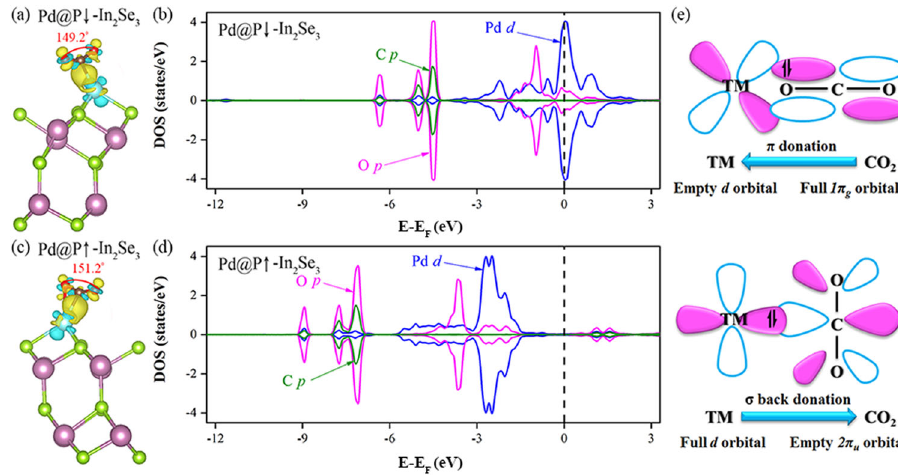
Fig. 2 Tunable activation of CO 2 by polarization switching. The differential charge density plots and partial density of states of CO 2 adsorbed on Pd@In 2 Se 3 ( a , b for Pd@P ↓ -In 2 Se 3 , and c , d for Pd@P ↑ -In 2 Se 3 ). e Simpli fi ed schematic diagrams of CO 2 bonding to transition metals.